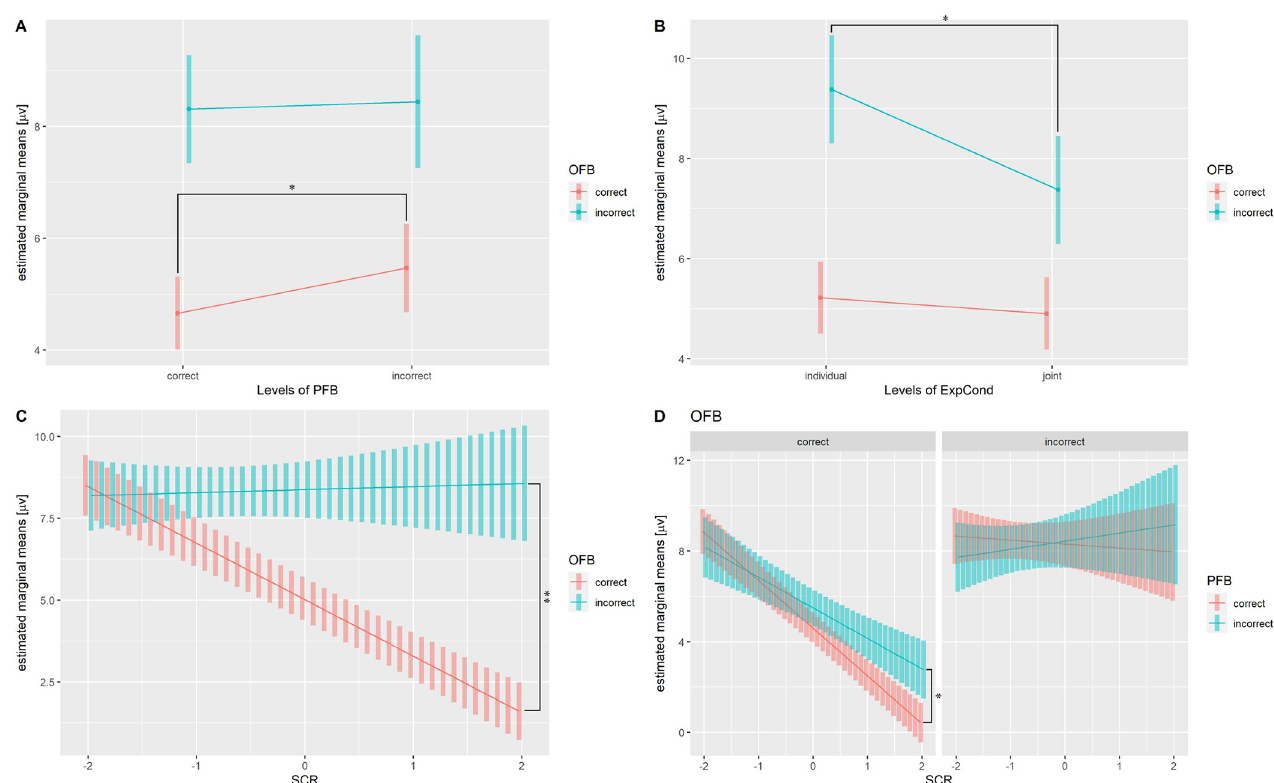
Fig 6. Estimated marginal means of gain- and loss-related P300s. (A) Interaction of OFB and PFB. (B) Interaction of OFB and ExpCond. (C) Interaction of OFB and SCR. (D) Interaction of OFB, OFB, and SCR. � p < 0.05, �� p < 0.01.